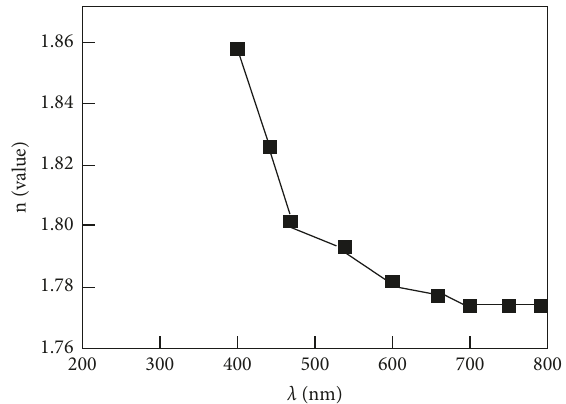
Figure 5: Dispersion curves of refractive index n of nanomaterial samples.